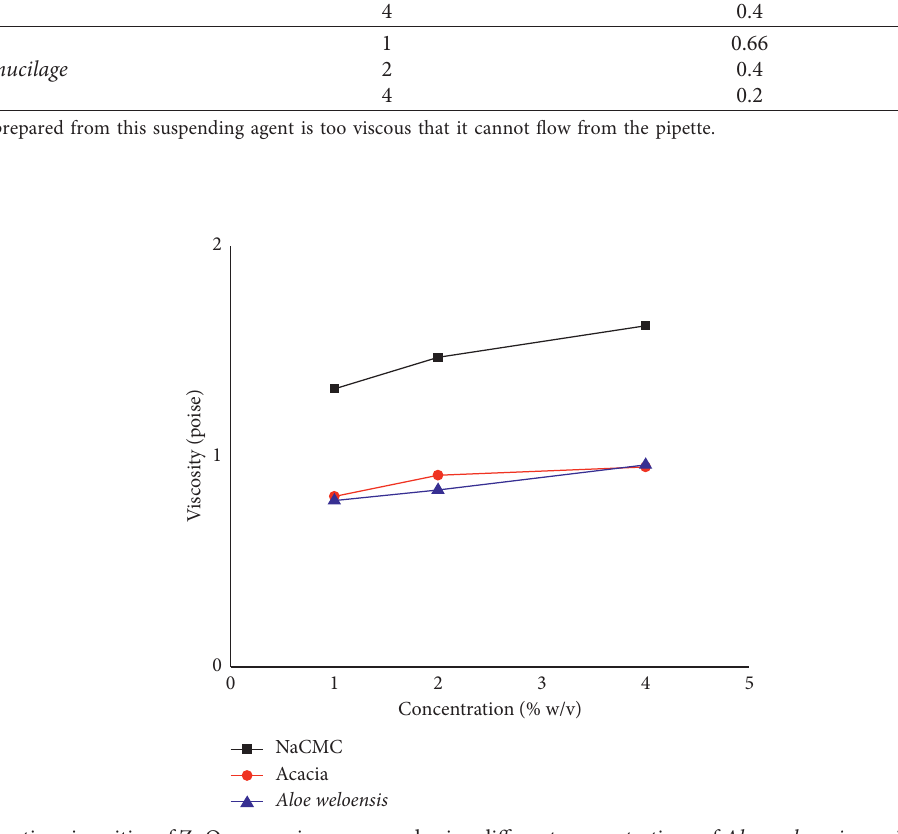
Figure 1: Comparative viscosities of ZnO suspensions prepared using different concentrations of Aloe weloensis mucilage, acacia gum, and NaCMC as suspending